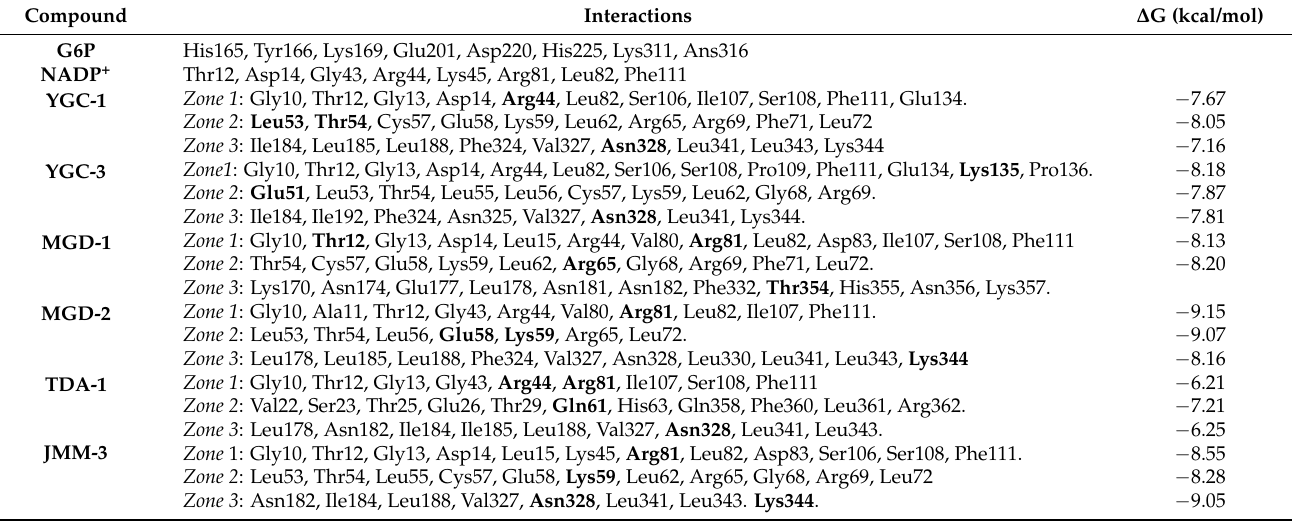
Table 2. Interactions of compounds with HpG6PD. The amino acids in bold are the hydrogen bond interactions. Compound Interactions ∆ G (kcal/mol) G6P His165, Tyr166, Lys169, Glu201, Asp220, His225, Lys311, Ans316 NADP + Thr12, Asp14, Gly43, Arg44, Lys45, Arg81, Leu82,